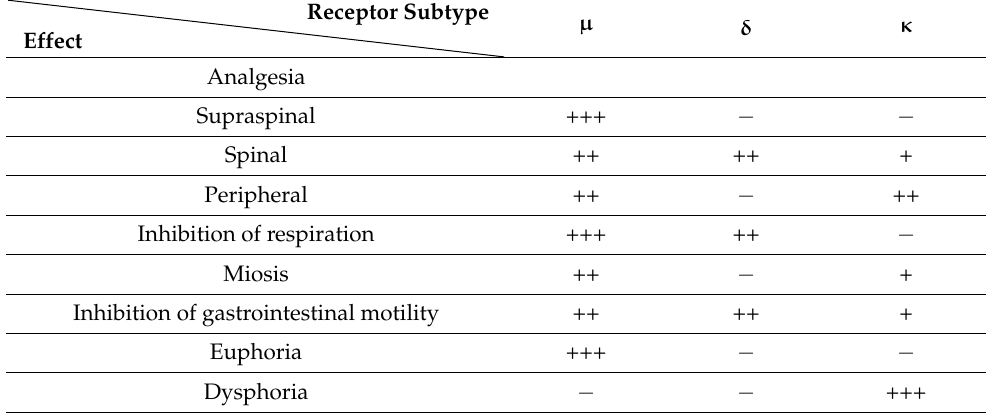
Table 2. Functional activity associated with various types of opioid receptors (according to [1]).